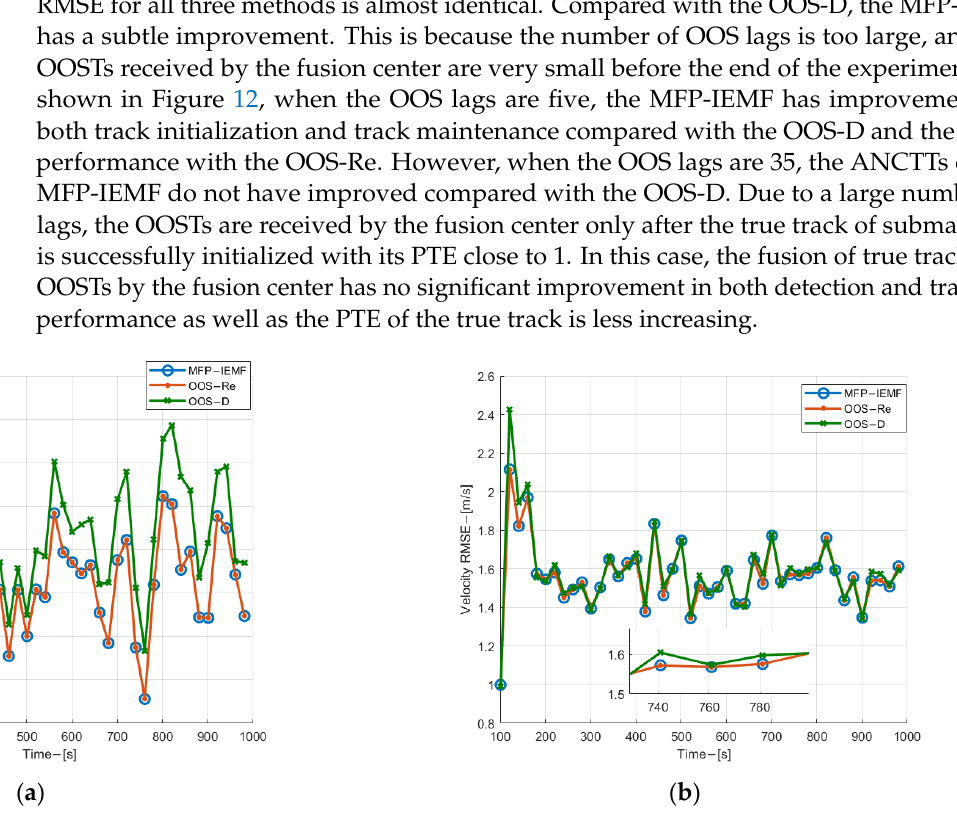
Figure 9. ANCTTs in experiment 2.